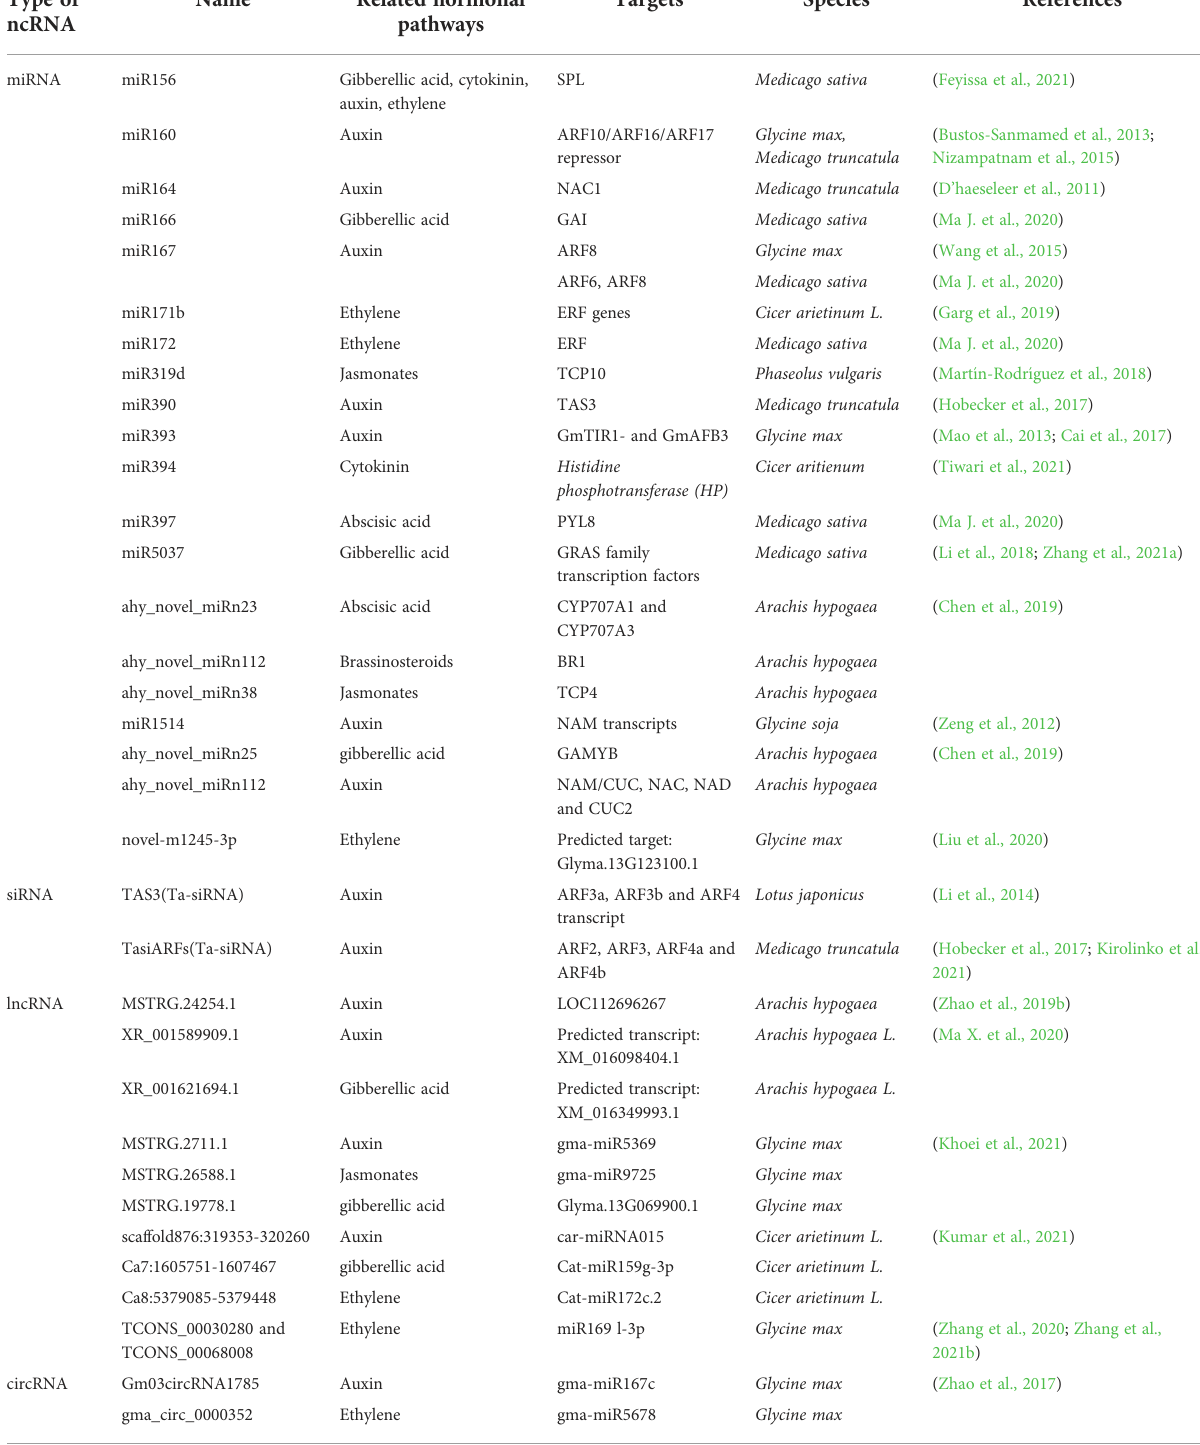
TABLE 1 Non-coding RNAs (ncRNAs) related to hormone signal